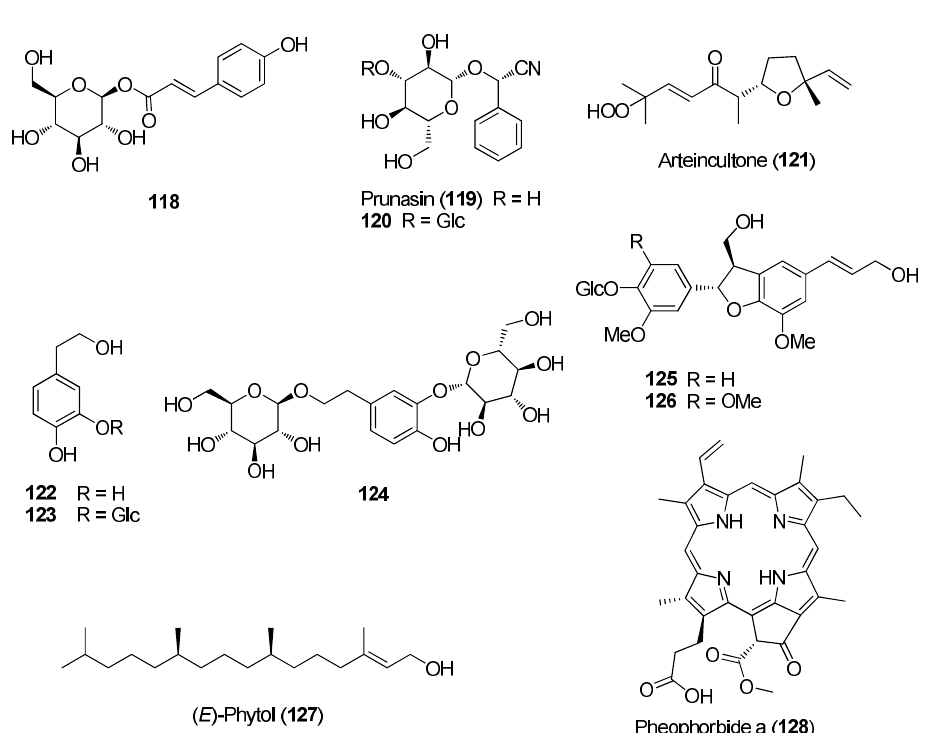
Figure 8. Representative phenolics, lignans and miscellaneous compounds isolated from Teucrium chamaedrys and Teucrium polium.